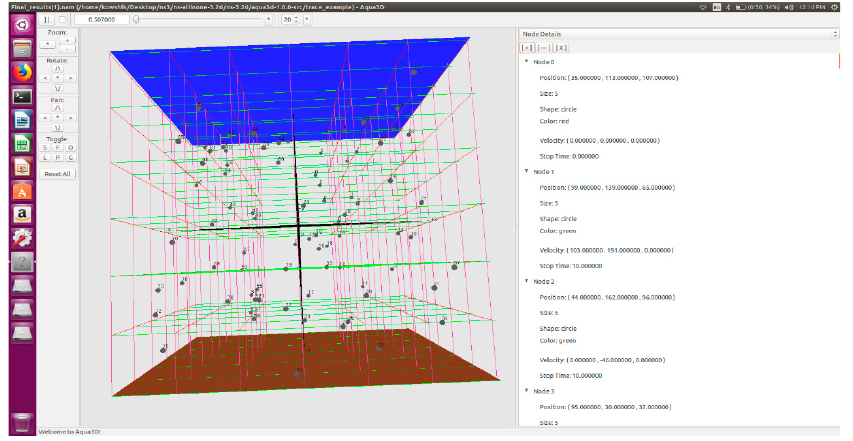
Figure 2. Sensor Node Deployment.